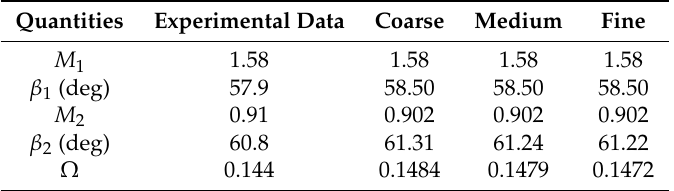
Table 6. Global quantities with different grid refinements.